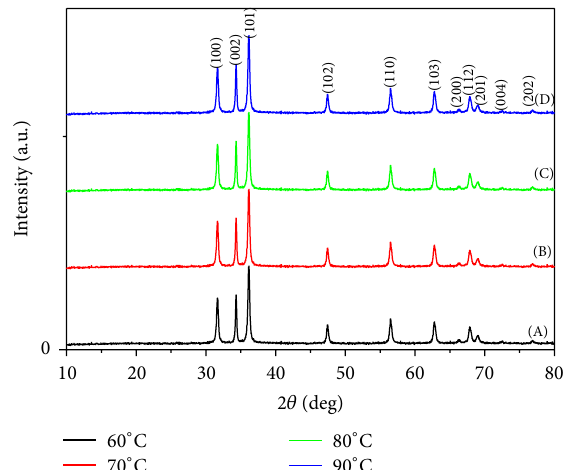
Figure 11: XRD patterns for ZnO nanopowders via hydrothermal technique at different reaction temperatures: (a) 60 ∘ C, (b) 70 ∘ C, (c) 80 ∘ C, and (d) 90 ∘ C.